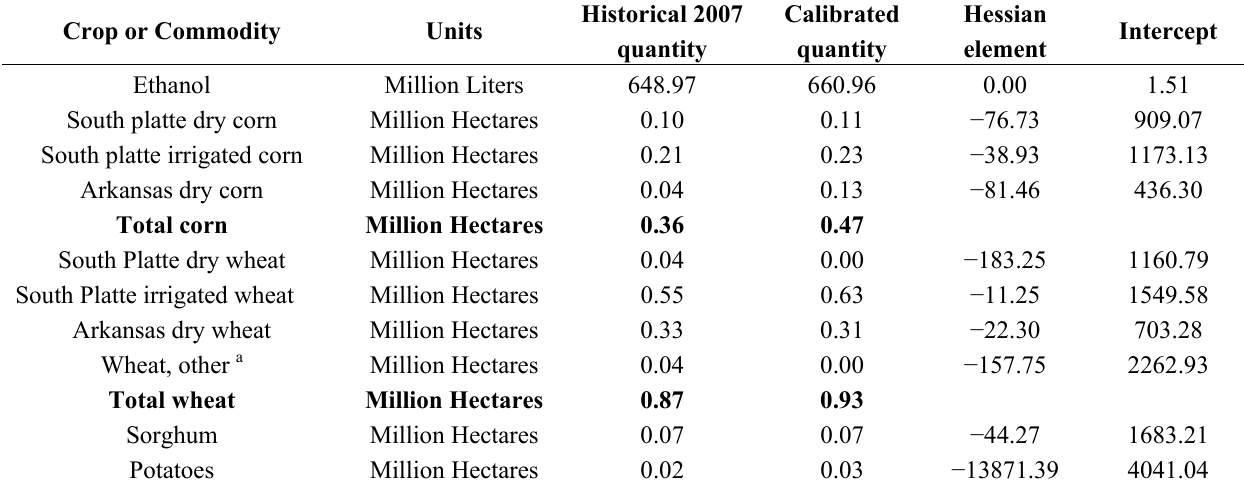
Table A1. Area and production of crops and livestock activities, actual, and calibrated values for the Colorado